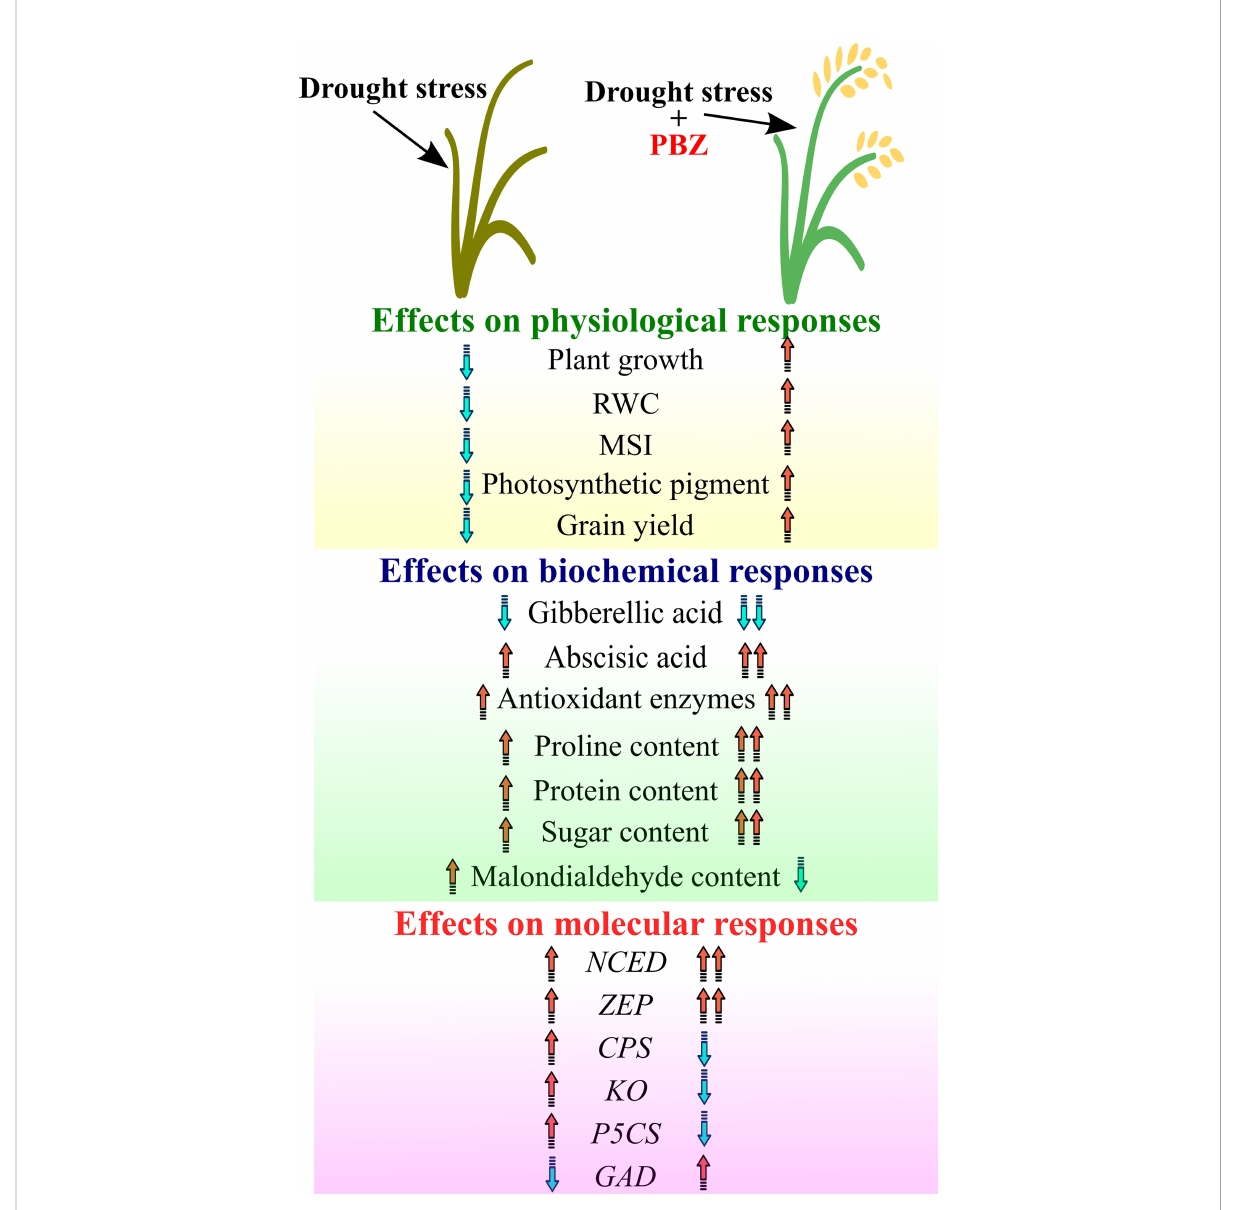
FIGURE 2 Depiction of overall impact of paclobutrazol under drought on physiological, biochemical, and molecular responses. Arrow showing the trend (Upward-Increase; Downward-